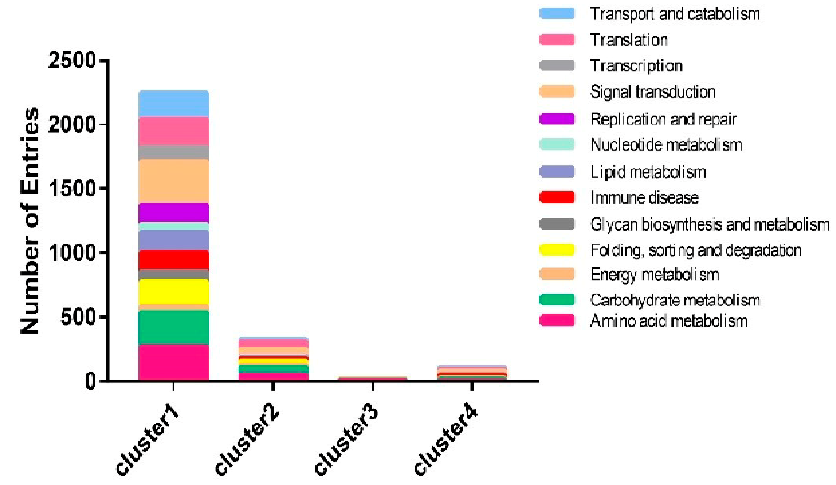
Figure 6. Functional classification of DEGs.